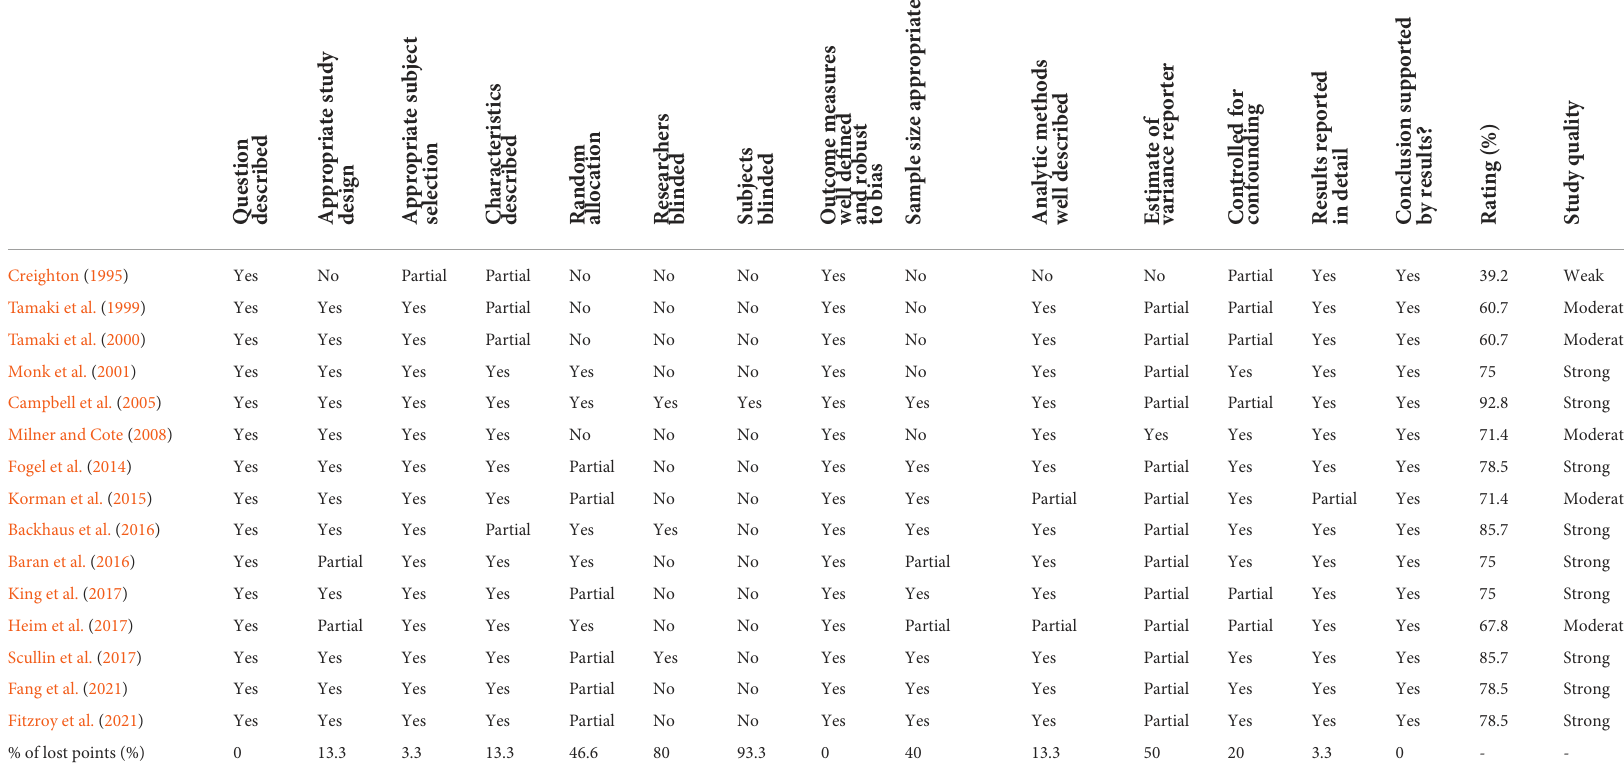
TABLE 2 Quality assessment of the